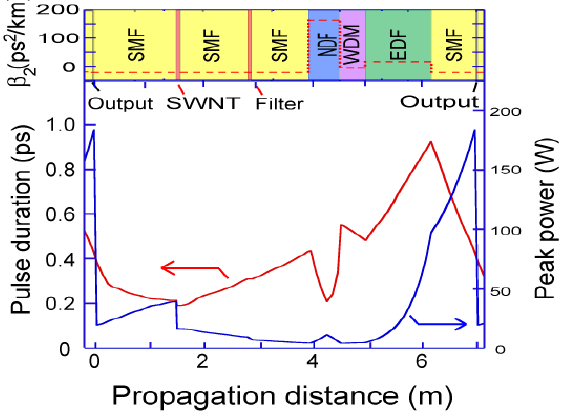
Figure 12. Dynamics of pulse propagation inside the fiber laser cavity for the stretched-pulse mode-locking